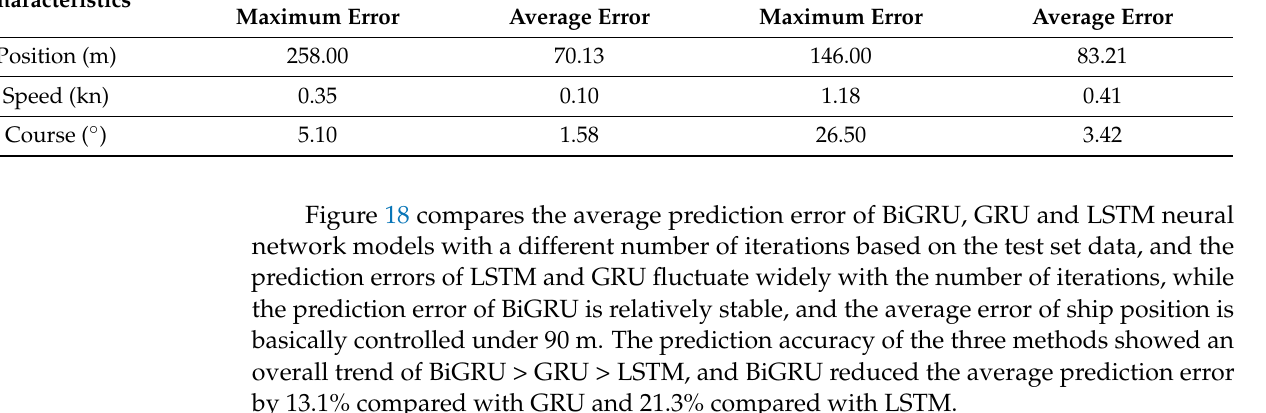
Figure 17. Real AIS trajectory prediction results.